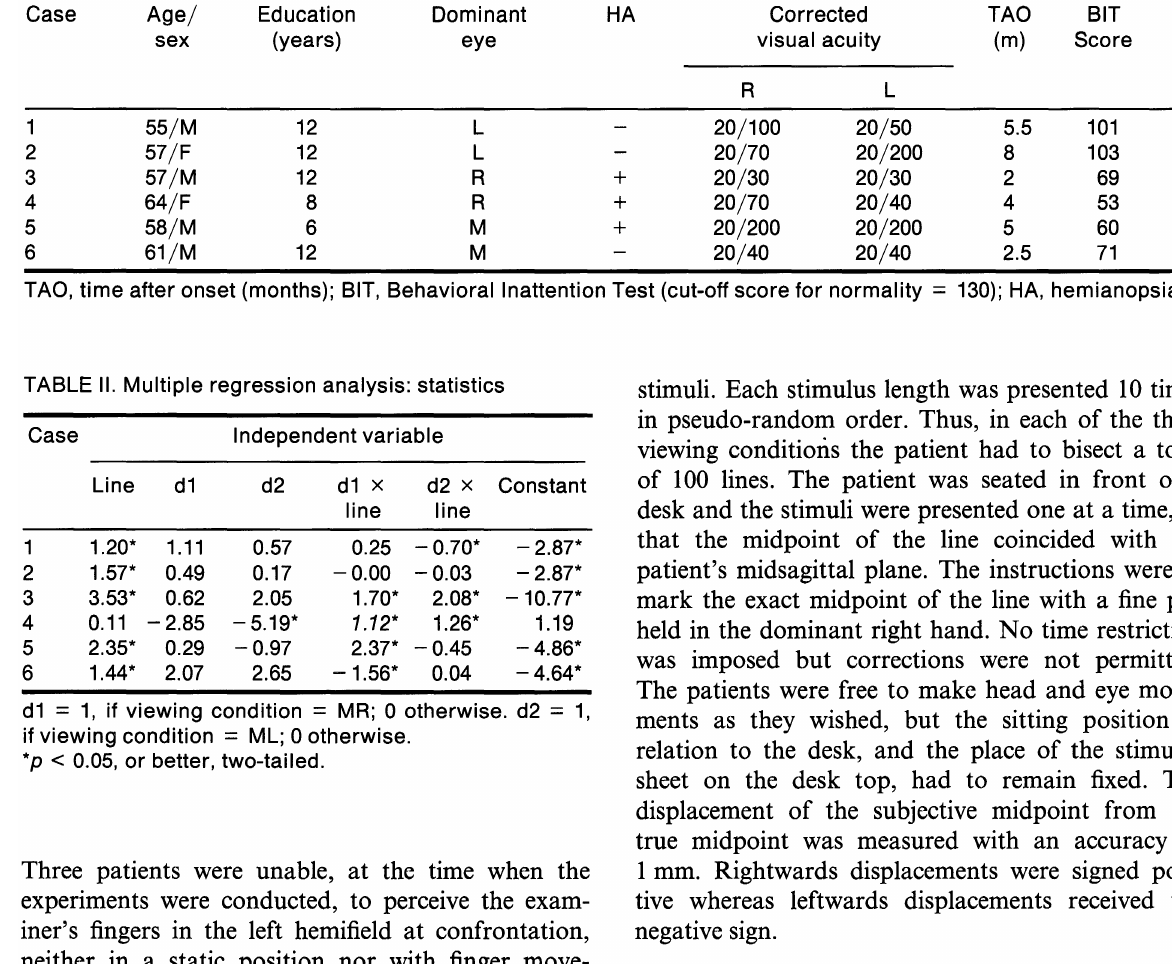
TABLE I. Patients' data Case